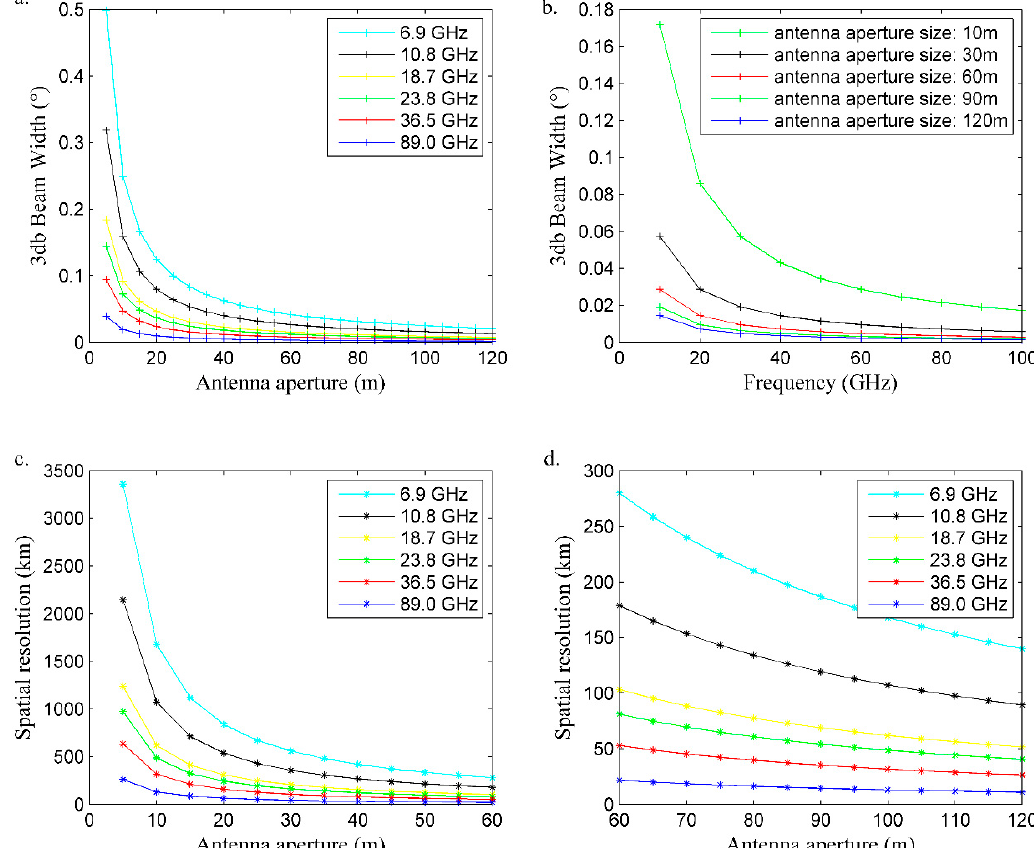
Figure 6. ( a ) The change of the half-power beam width with the antenna aperture; ( b ) the change of half-power beam width with the frequency; ( c ) the spatial resolution of MBMR under different antenna aperture sizes of 0 – 60 m; ( d ) the change of spatial resolution of MBMR with an antenna aperture size of 60 – 120 m.